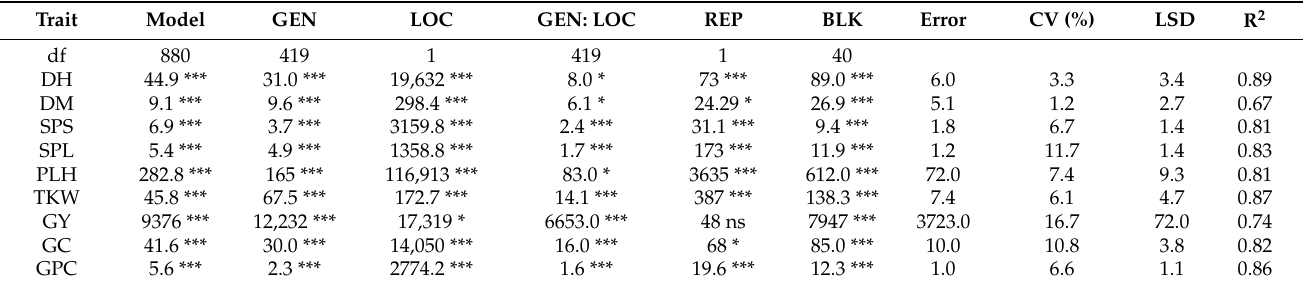
Table 2. Combined analysis of variance for 11 traits of 420 durum wheat genotypes tested at two locations (Sinana and Chefe Donsa) during